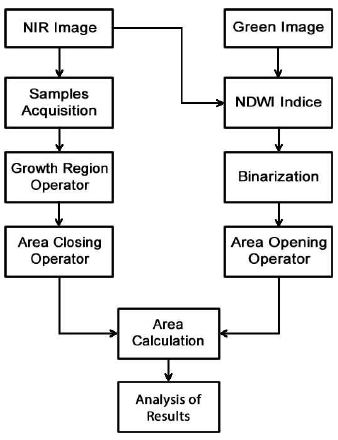
Figure 5: Reservoir flooded area calculation methodology.